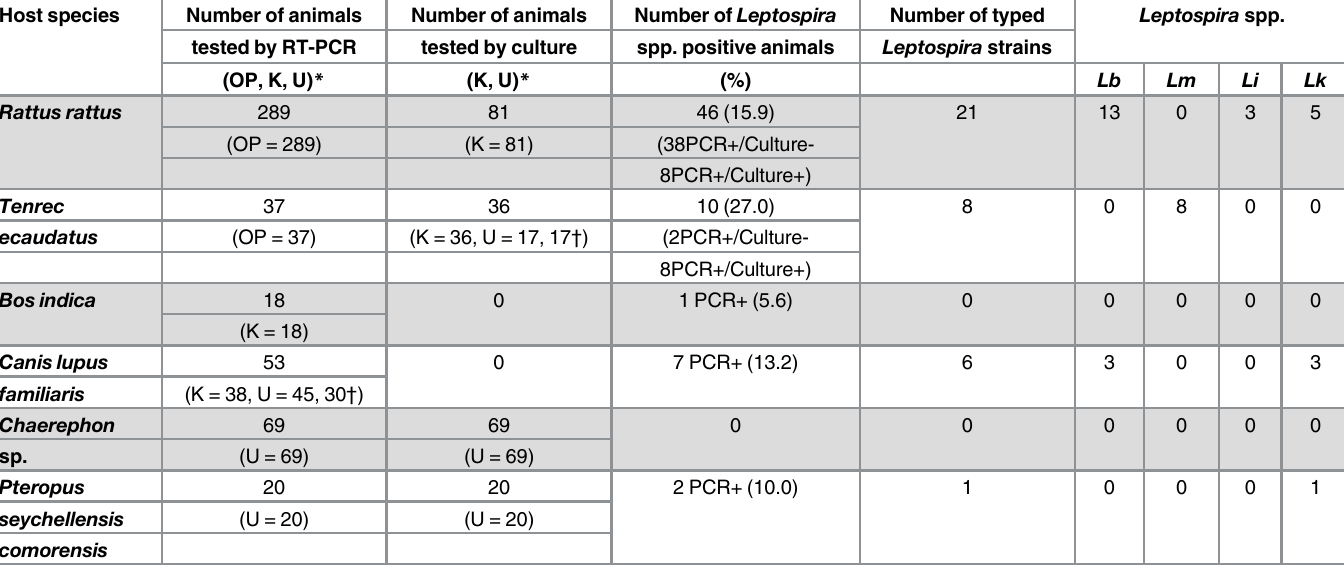
Table 1. Animals from the wild and domestic fauna of Mayotte tested for carriage of Leptospira spp. by real-time PCR, culture, and